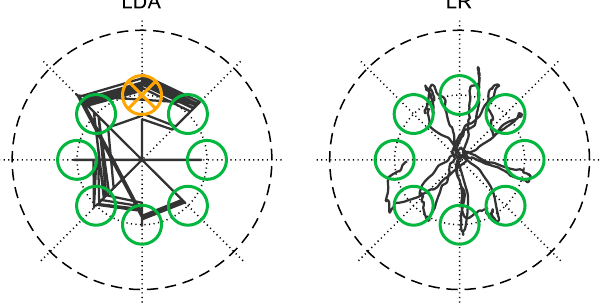
Figure 2. Qualitative presentation of one real-time validation run for the regression-based and for the classification-based control for a representative subject. The black curve indicates the trace of the curser and the circles the target positons. Green circles were successfully hit; yellow circles were entered at least once but not hit due to insufficient dwell time. LDA: Classification by linear discriminant analysis; LR: Linear